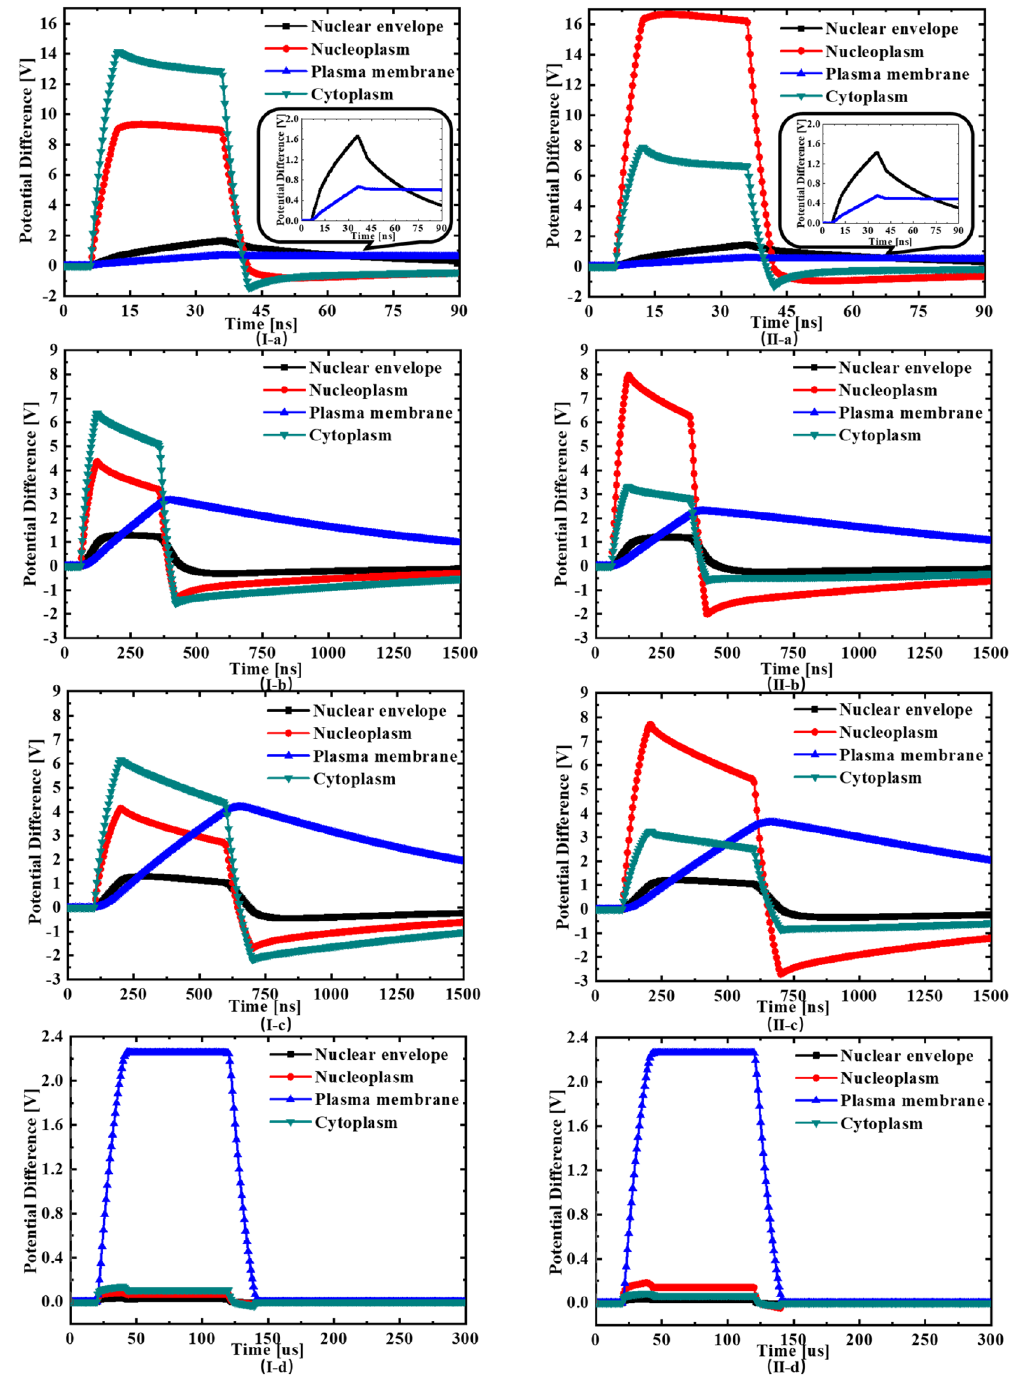
Figure 1. The simulated potential difference evolutions in the 2-D rotating models of the normal ( I-a , b , c , d ) and cancerous ( II-a , b , c , d ) cell suspended in a conductive solution between parallel electrodes biased with different time width pulses; ( I , II-a ): pulse width is 30 ns, voltage is 50 V; ( I , II-b ): pulse width is 300 ns , voltage is 25 V; ( I , II-c ): pulse width is 500 ns, voltage is 25 V; ( I , II-d ): pulse width is 100 μs, voltage is 5